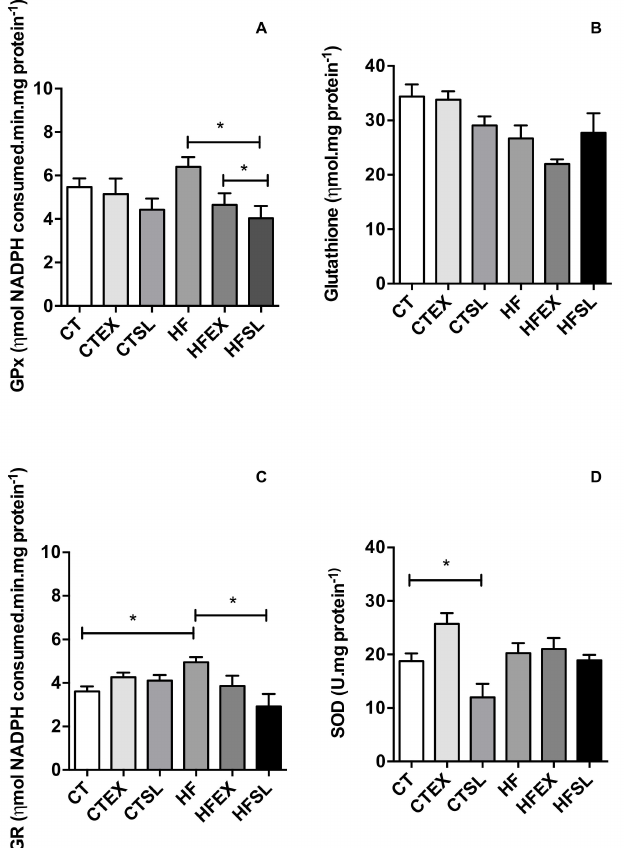
Figure 6. Activity of the hepatic antioxidant enzymes. ( A ) superoxide dismutase (SOD); ( B ) total glutathione (GSH); ( C ) glutathione peroxidase (GPx); ( D ) glutathione reductase (GR) at the end of the experiment ( n = 5 animals per group). CT: control group; CTEX: control group supplemented with beet stalks and leaves ethanolic extract; CTSL: control group supplemented with dehydrated beet stalks and leaves; HF: high-fat diet; HFEX: high-fat diet supplemented with beet stalks and leaves ethanolic extract; HFSL: high-fat diet supplemented with stalks and dried beet leaves. * Statistically significant difference ( p <